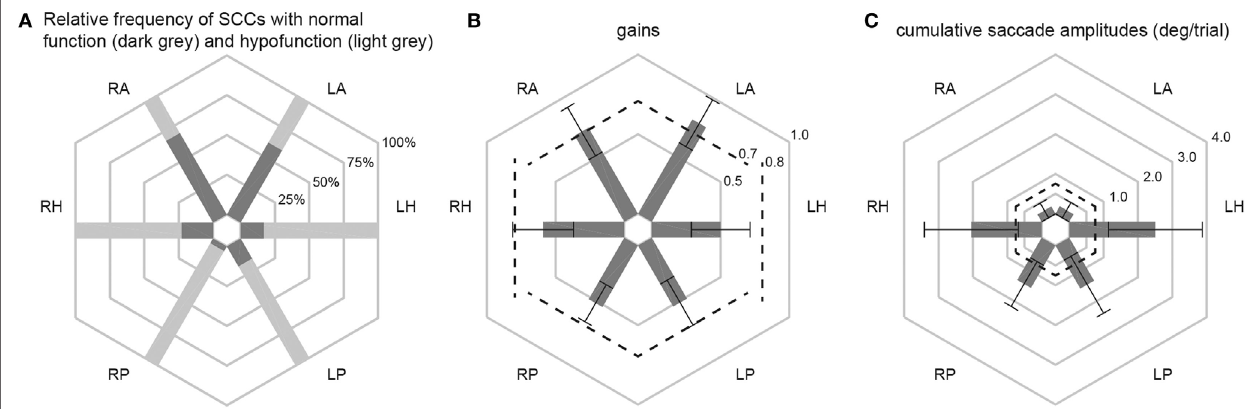
FigUre 2 | In panel (a) , the percentage of patients with normal function (dark gray shaded areas) and with hypofunction (light gray shaded areas) for the different semicircular canals (SCCs) are illustrated in a hexplot. Median ( ± 1 median absolute deviation) gains (B) and cumulative saccadic amplitudes (c) of all patients ( n = 101) are shown separately. Gain values (from 0 to 1) and cumulative saccadic amplitudes (°/trial, from 0 to 4) are provided along the different hexagons. Cutoff values for reduced gains ( < 0.8 for the horizontal canals, < 0.7 for the vertical canals) and for abnormally increased cumulative saccade amplitudes ( > 0.73°/trial) are indicated by dashed